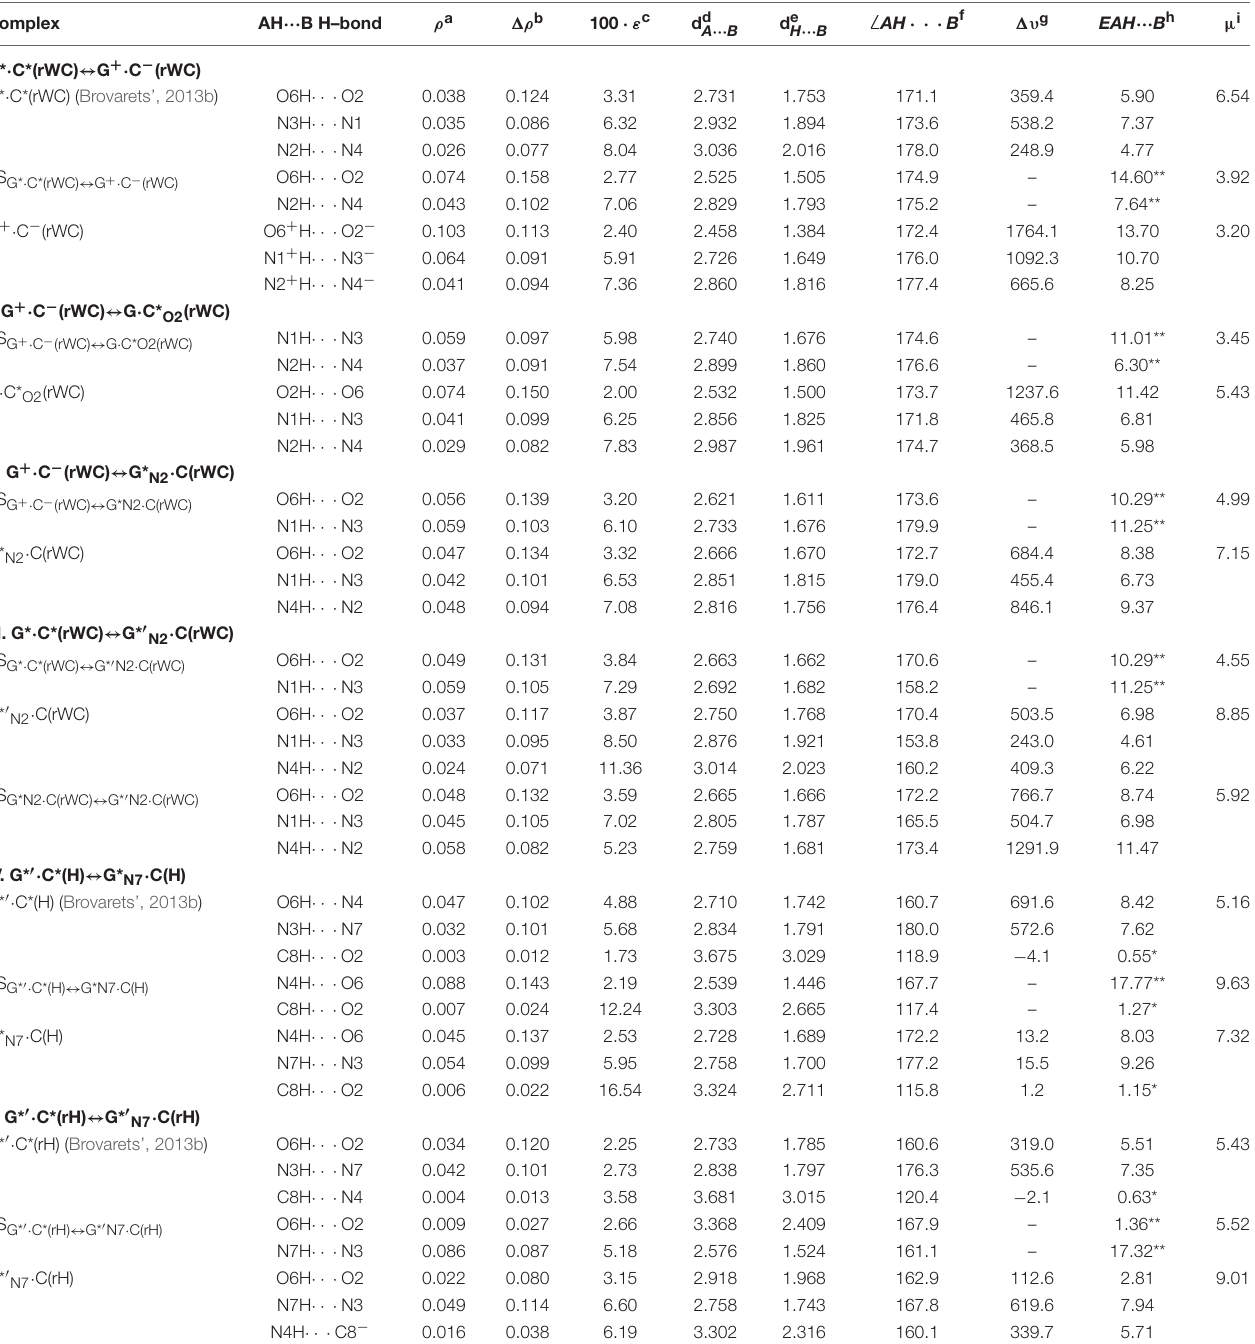
TABLE 2 | Electron-topological, geometrical, and energetic characteristics of the intermolecular H-bonds in the investigated DNA base pairs in rare tautomeric forms and TSs of their tautomerization via the SPT or DPT obtained at the